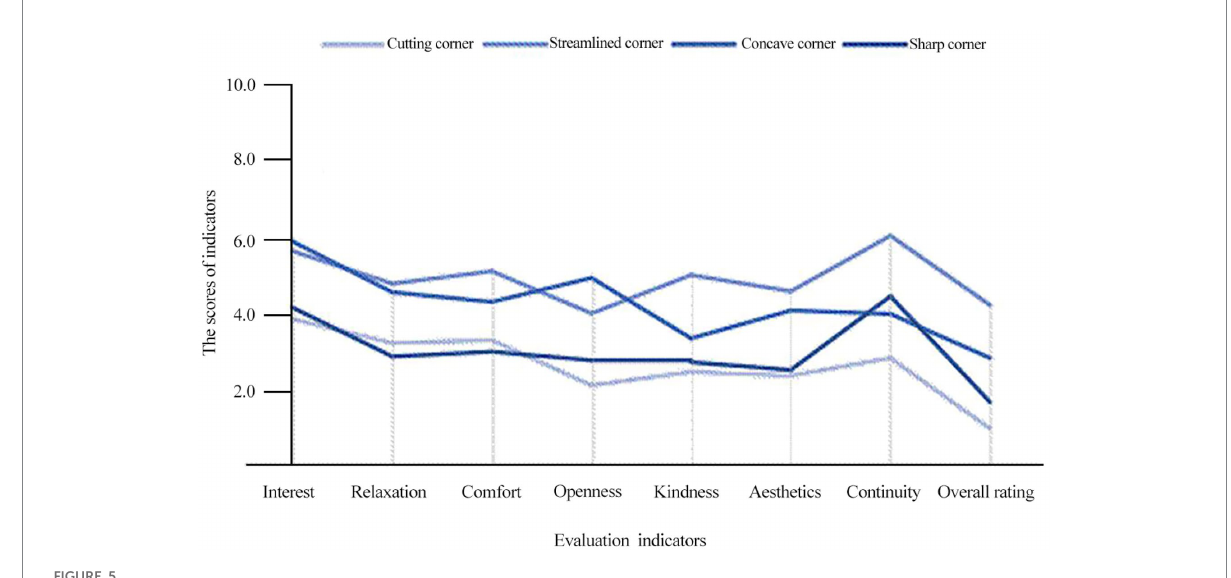
FIGURE. 5 Line chart of layout patterns and evaluation